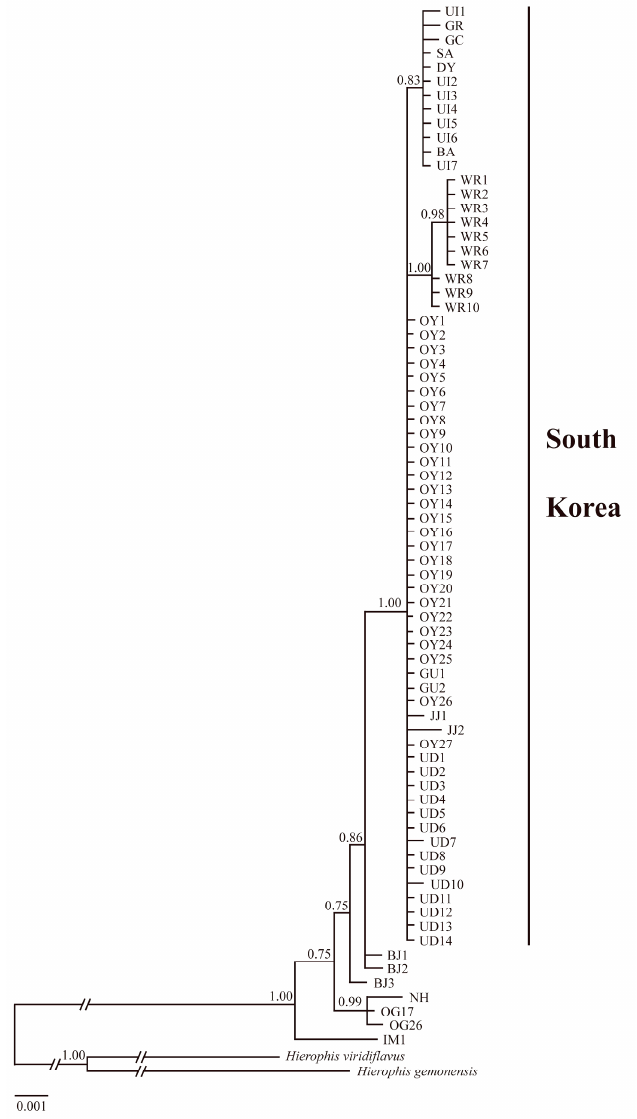
Figure 4. Bayesian inference (BI) tree of 74 Orientocoluber spinalis based on the concatenated mito- chondrial DNA ( Cytb + ND4 ; 1813 bp). Bayesian posterior probabilities (%) are reported above tree branches. Population abbreviations: OY, Oeyeondo; UD, Udo; WR, Woraksan; UI, Uido; JJ, Jejudo; GU, Gauido; BA, Buan; DY, Danyang; GC, Gochang; GR, Goryeong; SA, Shinan in South Korea; BJ, Beijing; IM, Inner Mongolia; NH, Ningxia in China; OG, Omnogovi in Mongolia.